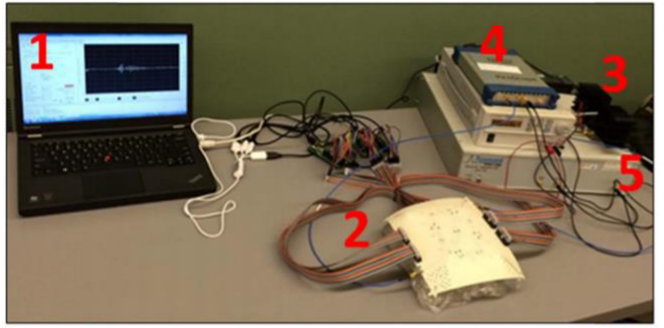
Figure 25. Microwave time-domain system for breast cancer imaging developed by Santorelli et al. [82]. The system components indicated on the photograph are ( 1 ) a laptop for transmitting control bits and saving the recorded data, ( 2 ) a flexible circuit board containing 16 antennas, the switching matrix, and the two micro-controllers, ( 3 ) the pulse shaping circuitry, ( 4 ) an oscilloscope, and ( 5 ) the impulse generator. Reprinted with permission from [82].